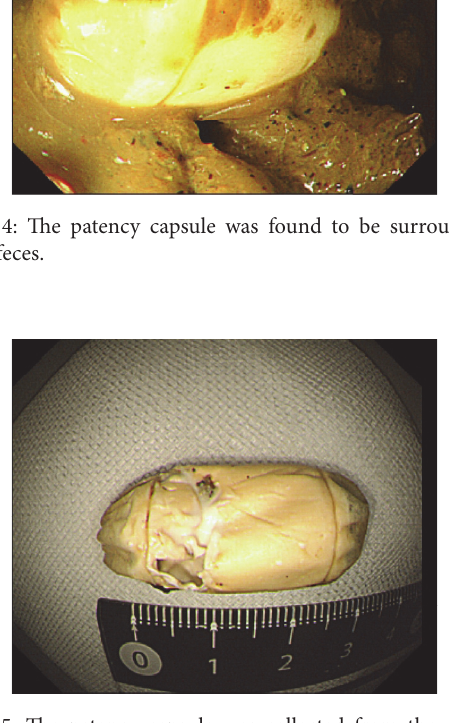
Figure 5: The patency capsule was collected from the colon by